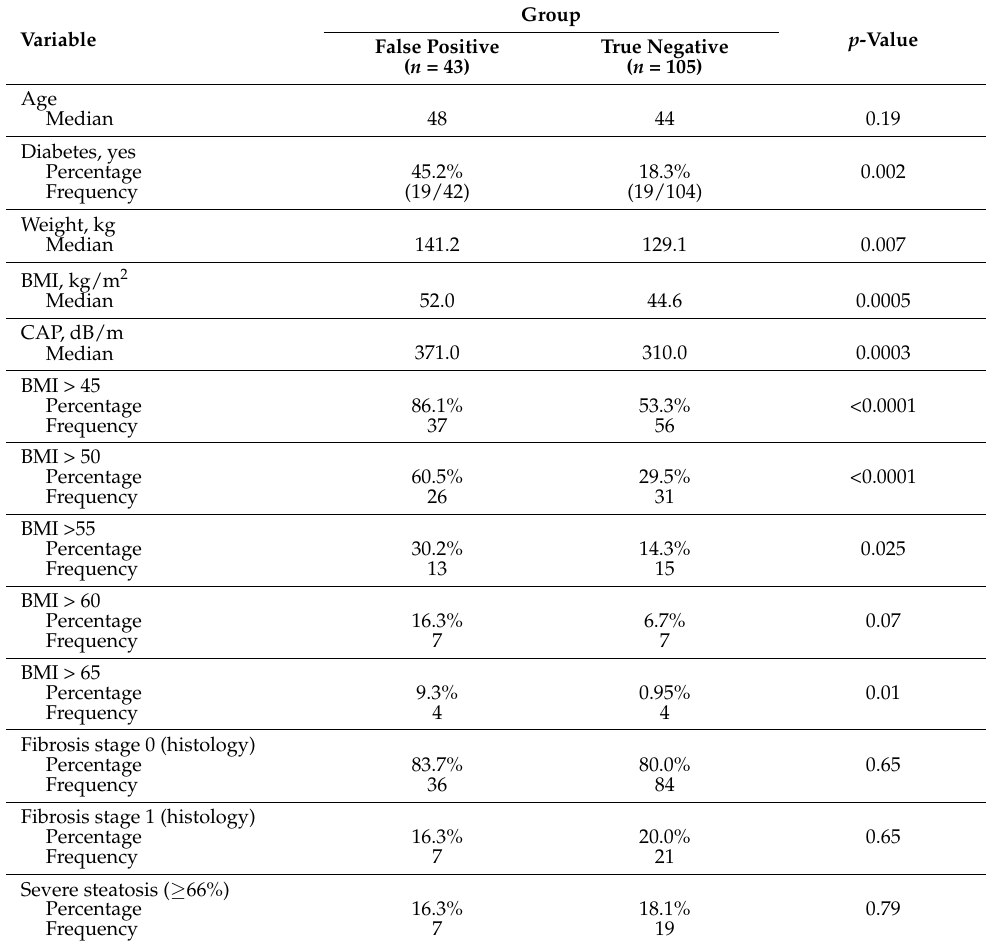
Table 5. Comparison between enrollee subjects with F0–F1 according to their LSM values ( ≥ 12.8 kPa false-positive cases and <12.8 kPa true-negative